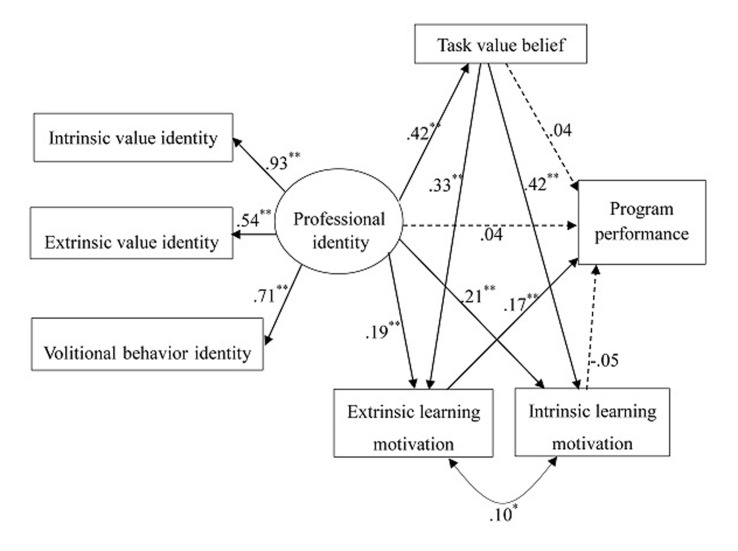
Full Model (Model 3). Model fit: χ2(8) = 28.10, p = 0.0005; CFI = 0.98, RMSEA = 0.06, 90% CI = 0.04 -0.09, SRMR = 0.02. ∗p ≤ 0.05, ∗∗p ≤ 0.01.